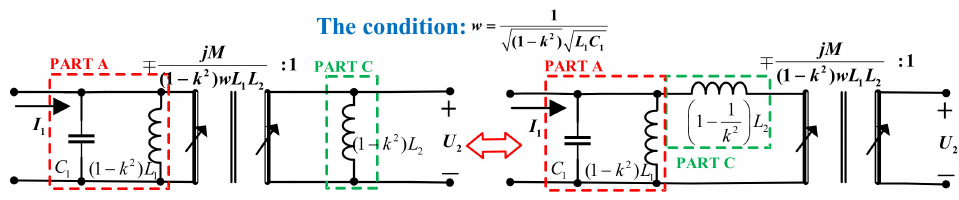
Figure 17. The equivalent model of the I_CC_CV circuit.